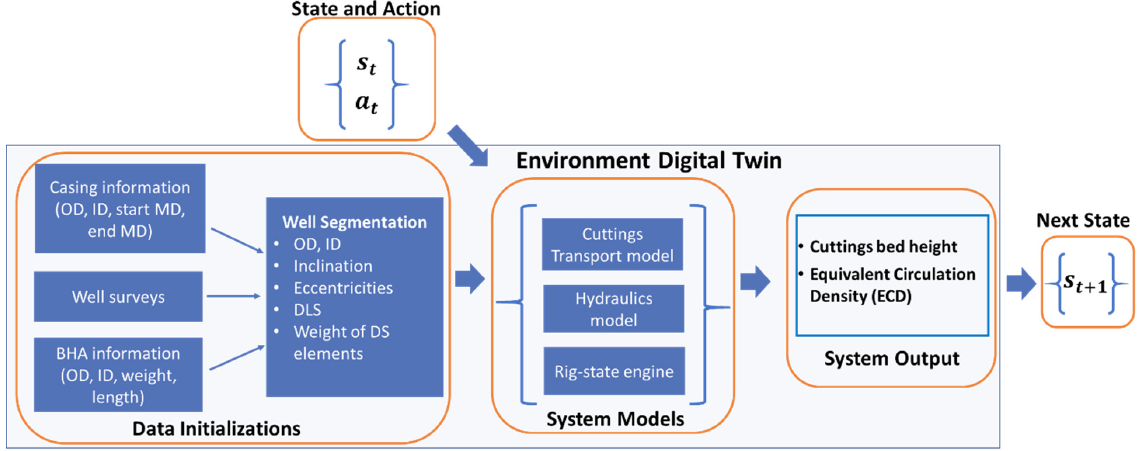
Figure 9. Digital twin of the hole cleaning system’s environment (see [18] for details on the models).